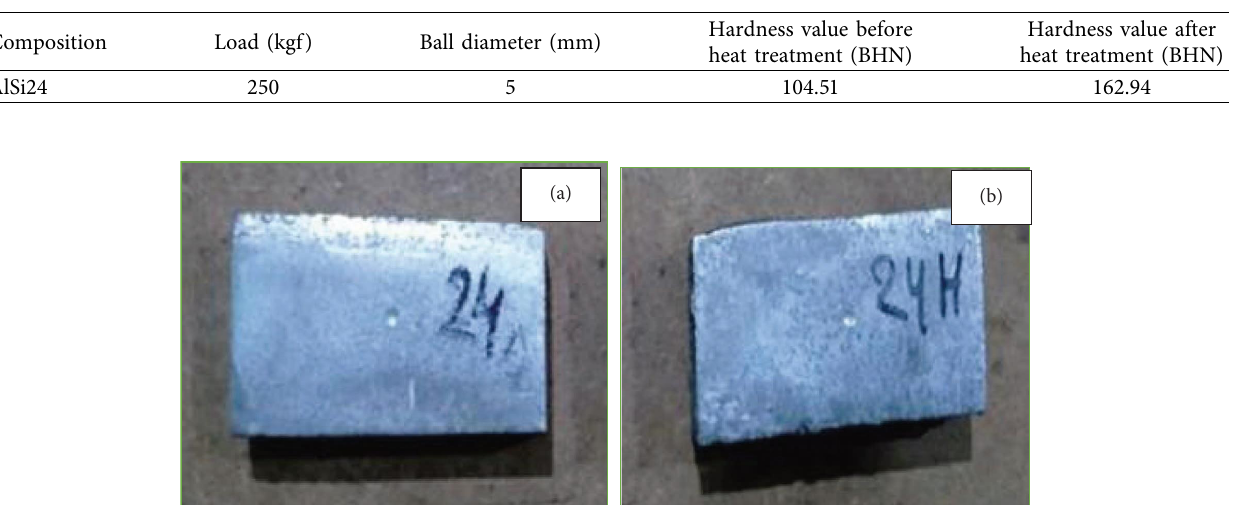
Figure 6: Hardness test alloys (a) AlSi24 (UVS) and (b) AlSi24